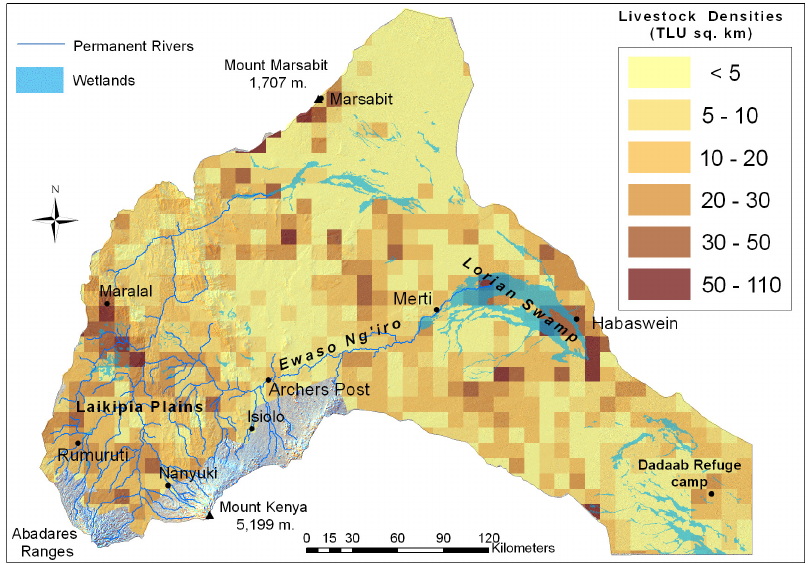
Figure 4. Average livestock density 1990–2010 (TLU per km 2 , [2] and